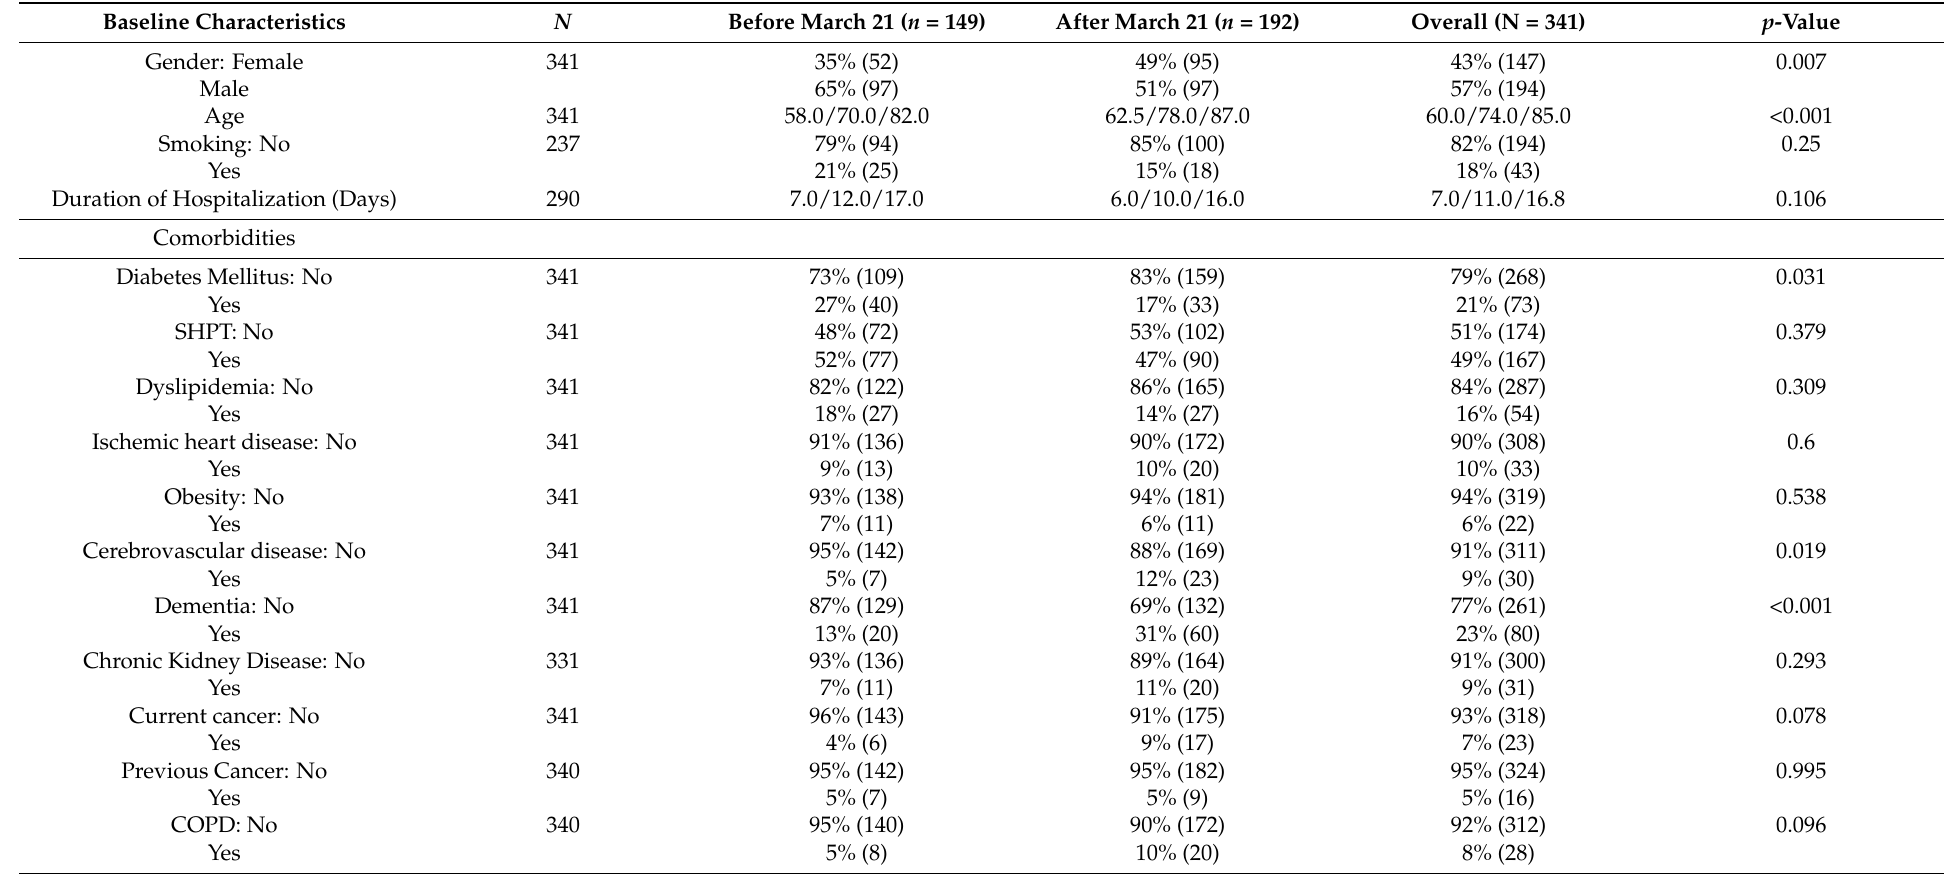
Table 1. Subjects’ baseline characteristics according to the admission date (before–after 21 March 2020). Data are I quartile/Median/III quartile for continuous variables and percentages (absolute numbers) for categorical